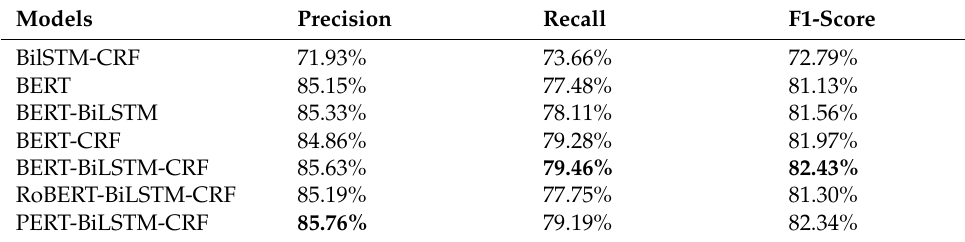
Table 5. Comparison of named-entity recognition experiment